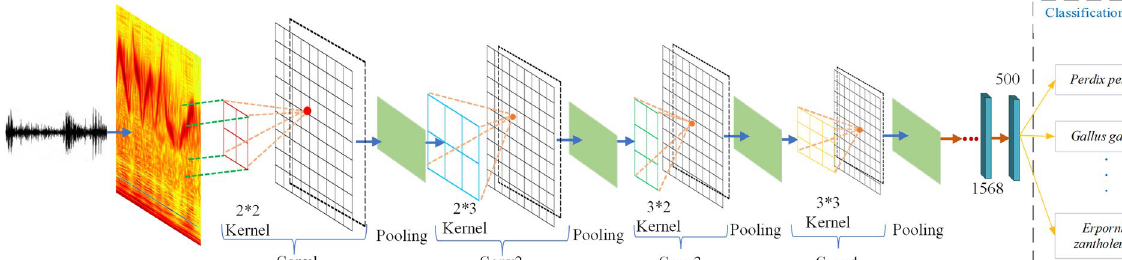
Figure 3. MSCNN model structure.